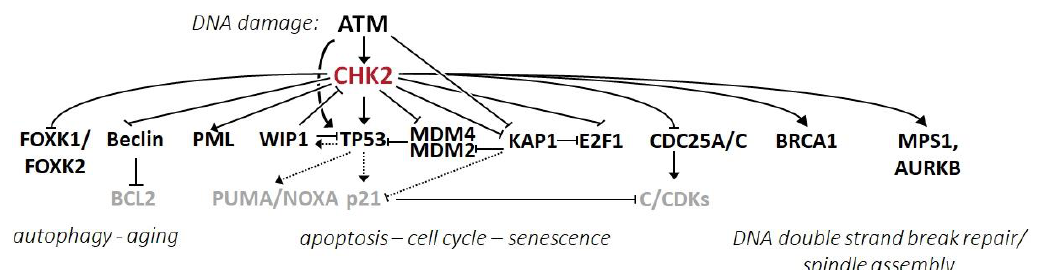
Figure 2. In the presence of DNA damage, especially in the presence of DNA double-strand breaks, sensor protein complexes (not shown) activate the apical kinase ATM phosphorylating CHK2. As an e ff ector kinase, CHK2 phosphorylates numerous substrates (described in the text) participating in critical pathways deregulated in the process of tumorigenesis.